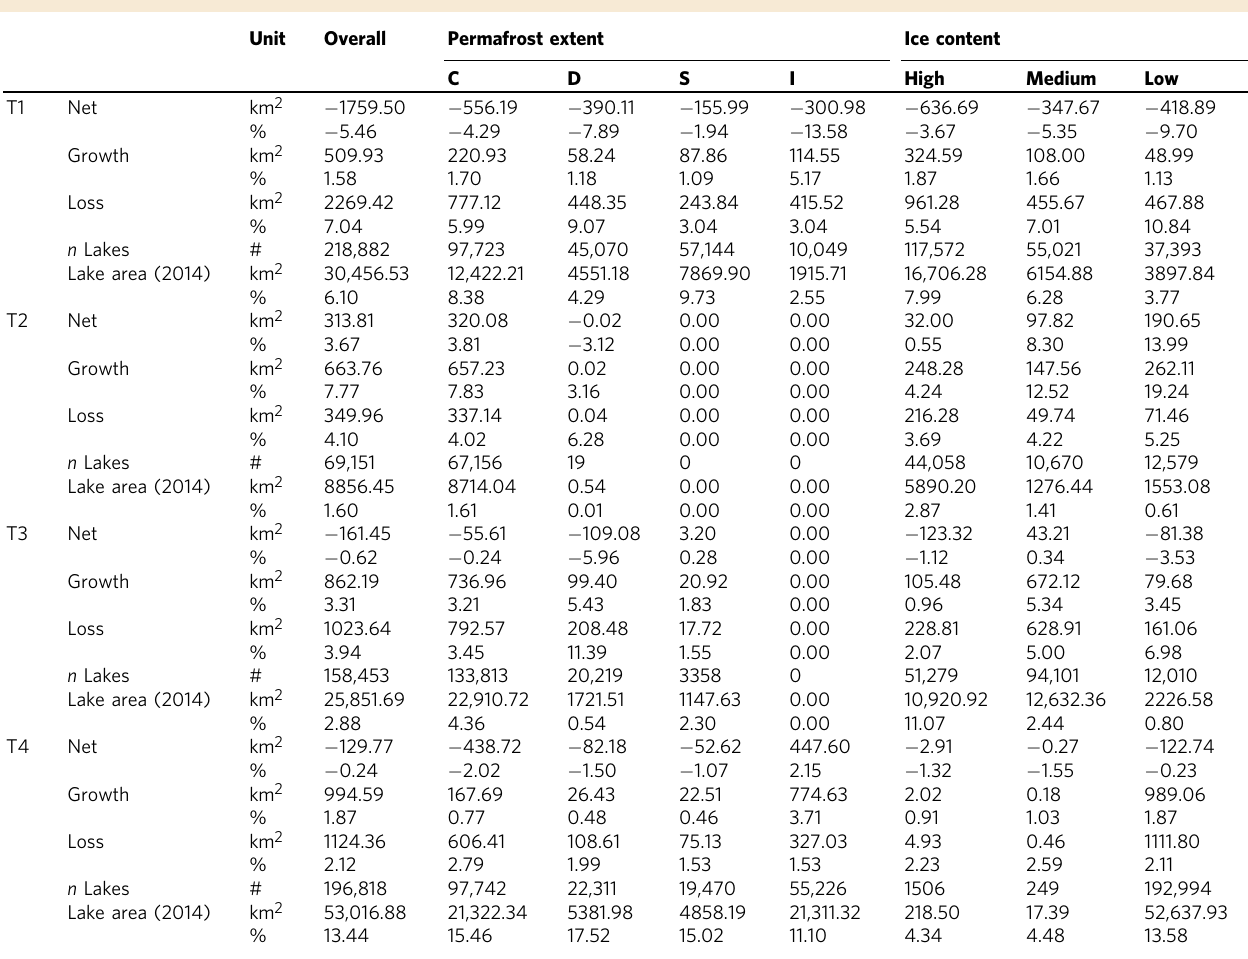
Table 1 Regional lake area and lake change statistics per study